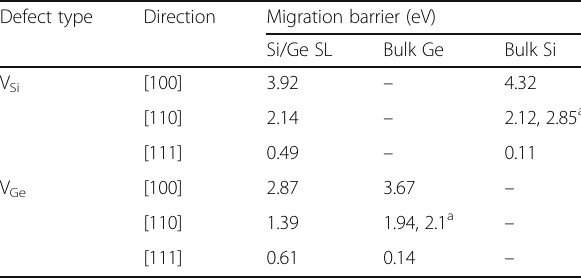
Table 4 The defect migration barrier in bulk Si, Ge, and Si/Ge superlattice. V X : X vacancy ( X = Si or